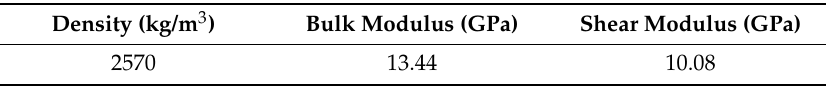
Table 1. Physico-mechanical properties of rock mass.